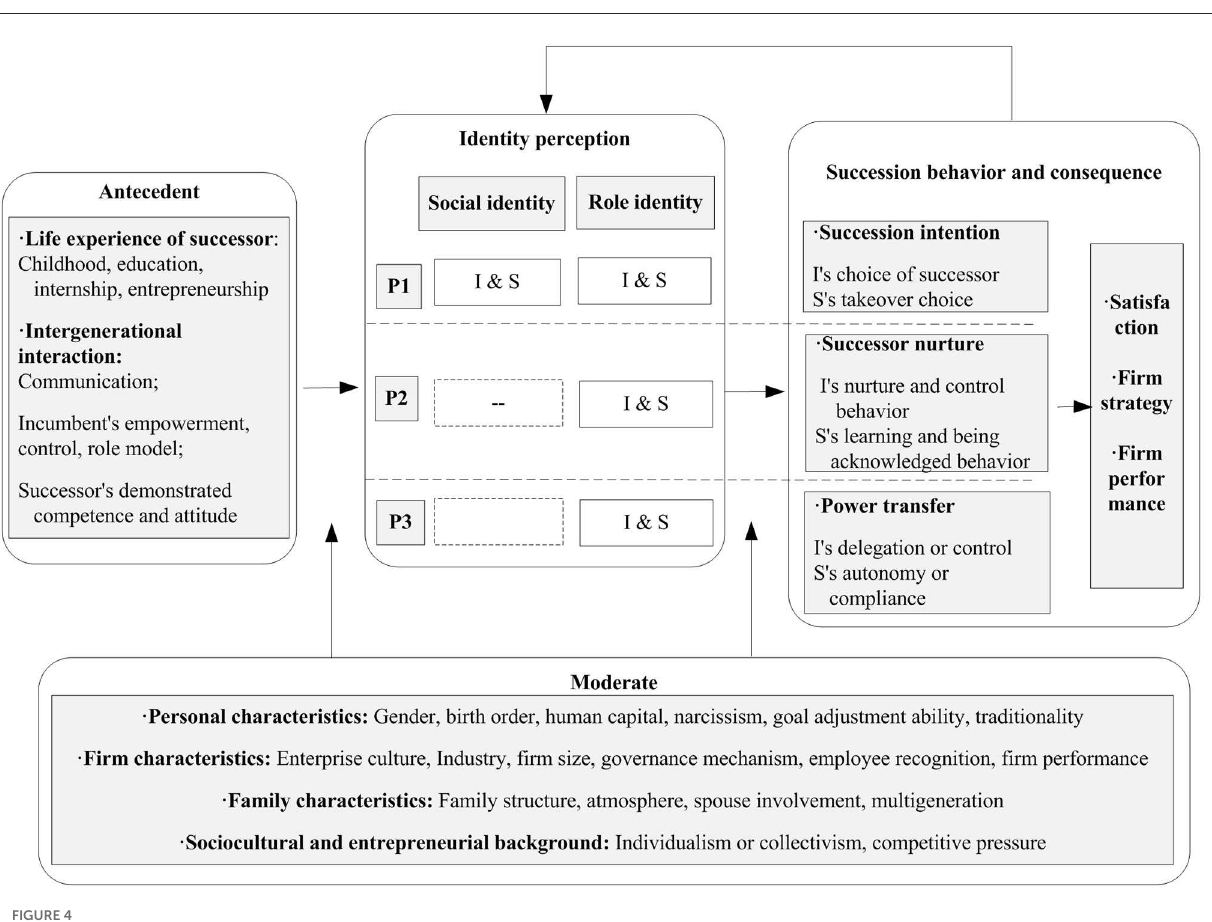
FIGURE4 Knowledge framework of succession from the identity